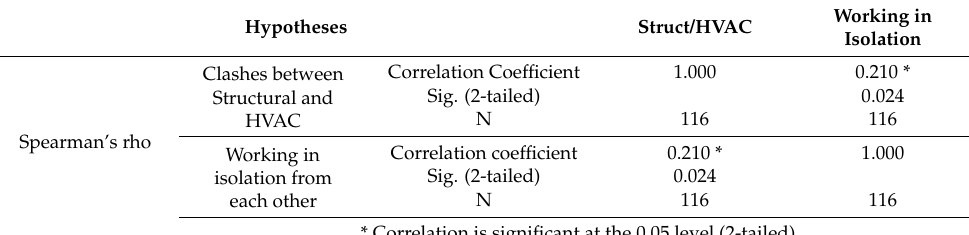
Table 5. Results of the Null hypotheses tested and their